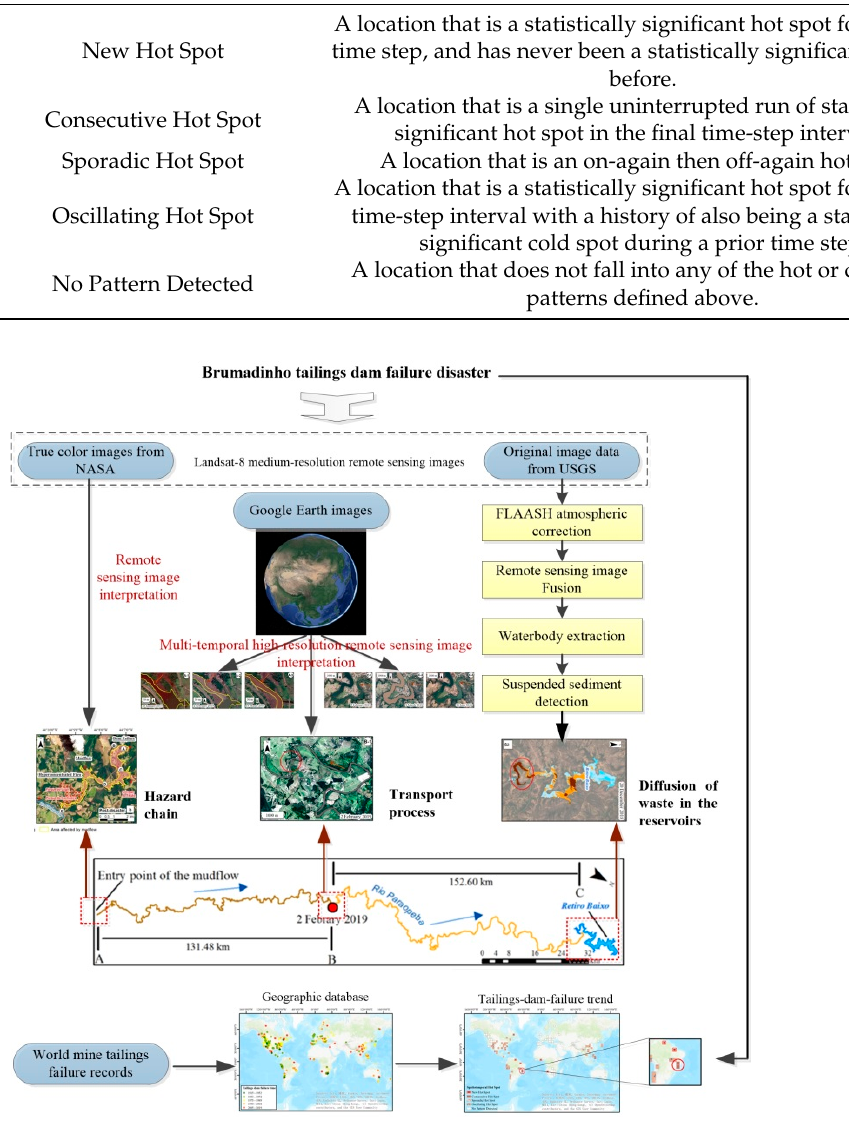
Figure 6. Technical